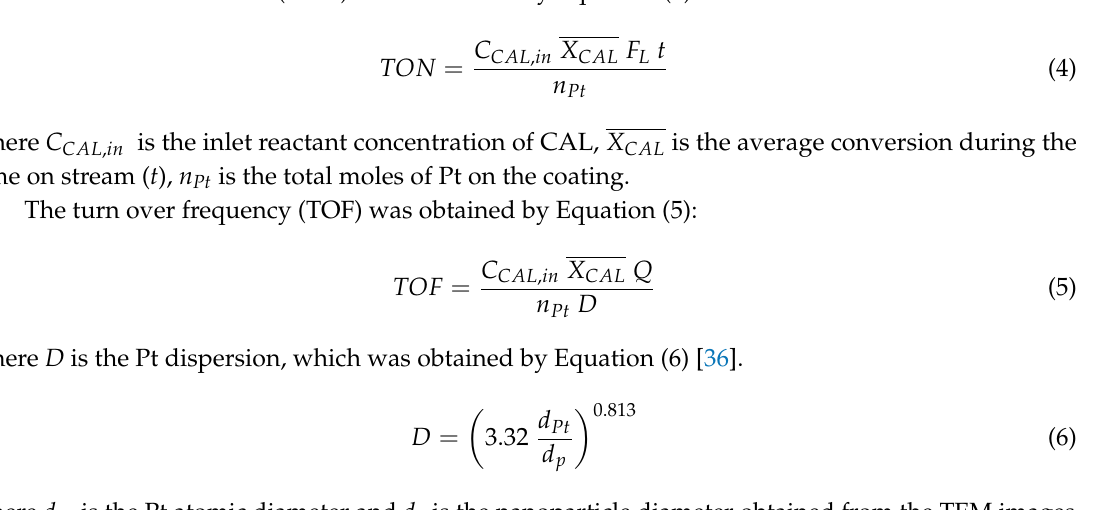
Figure S1. Acetal formation with CAL and HCAL. Figure S2. Increasing reaction rate with the reaction